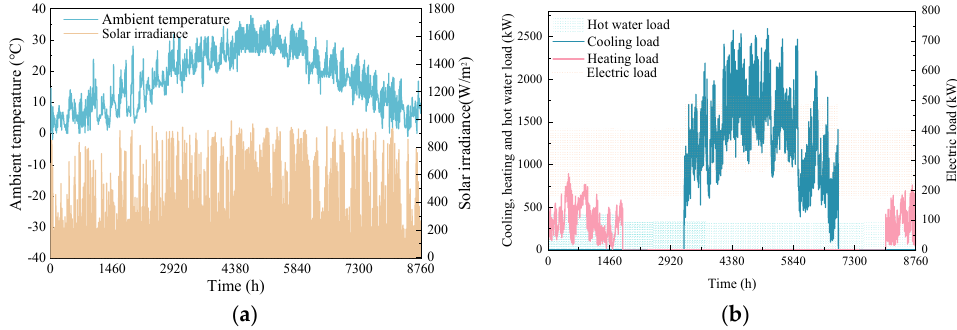
Figure 10. Outdoor parameters and building load under the operating conditions: ( a ) Annual outdoor meteorological parameters; ( b ) Building load under operating conditions.